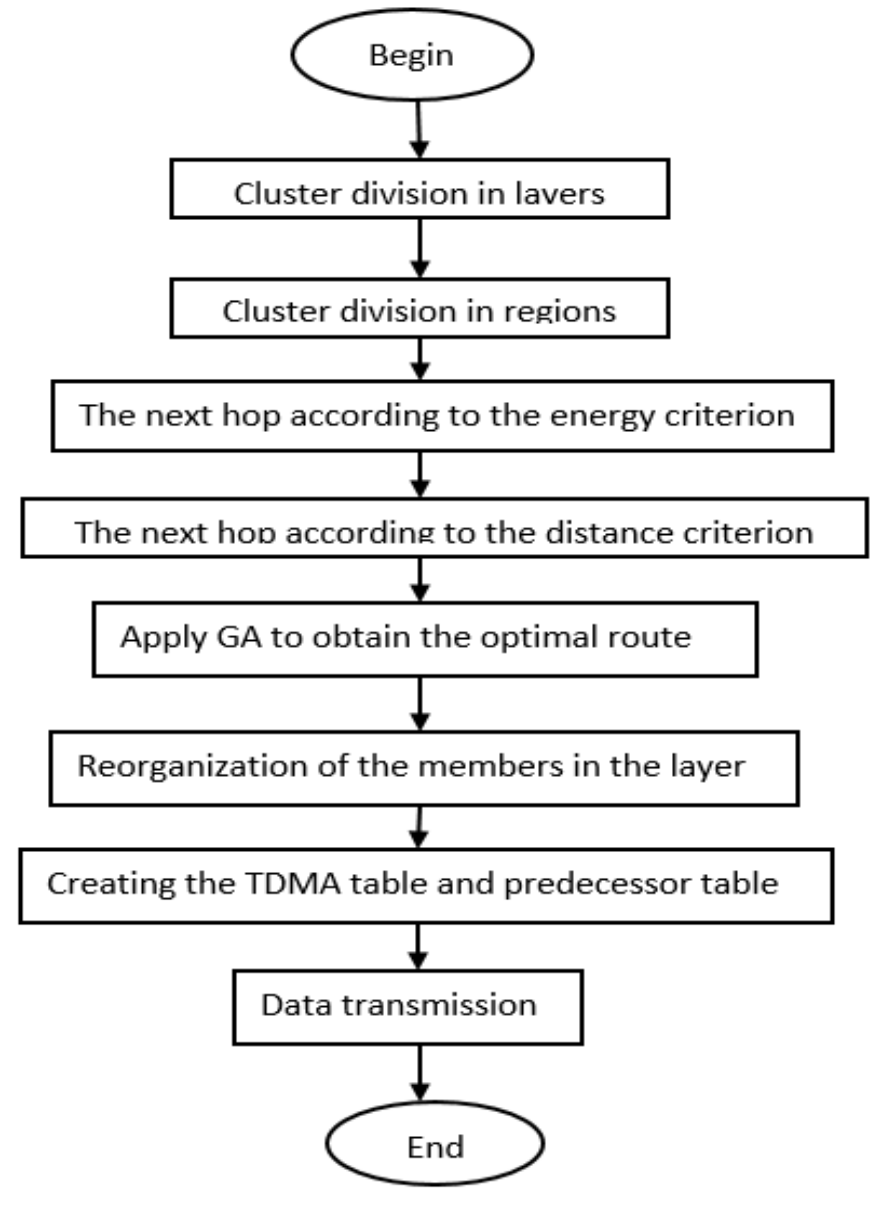
Figure 5. Path constructed with GA [45]. After finding the location of the optimal base stations using our proposed technique with a different number of nodes, we calculated the maximum network lifetime of different algorithms with the same nodes number for each. Figure 7 shows the maximum network lifetime of CECGA, GA, and SEGA for 100